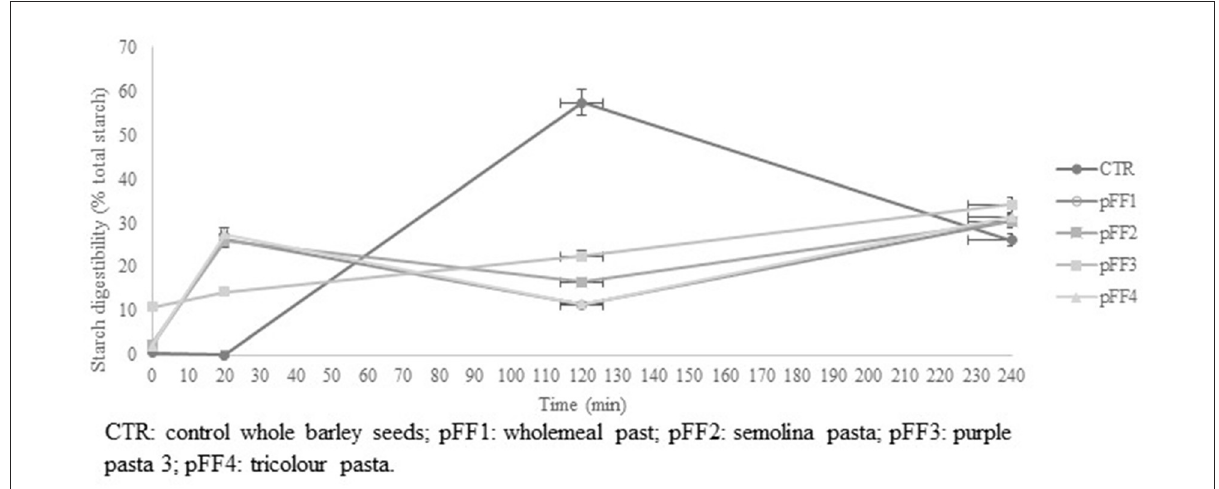
FIGURE2 In vitro starch digestibility over time of pFF and barley seeds